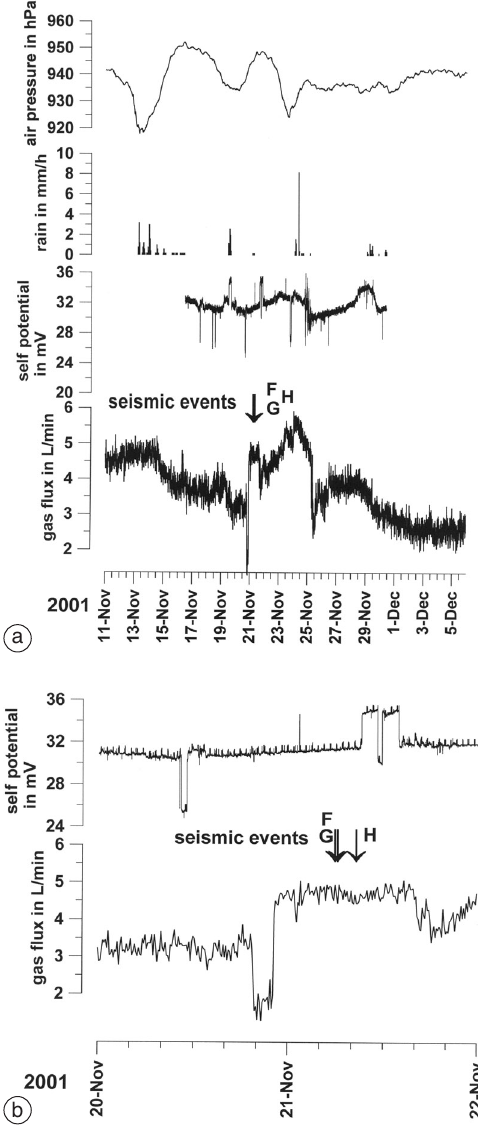
Fig. 5a,b. a) Temporal variation of the gas flux, rain and atmospheric pressure recorded at the Tramutola station and the self potential signal recorded at Mar- sico Nuovo in the period from November 11 to De- cember 6, 2001. Local seismic events in that period: F, G and H. b) Enlarged part of the temporal varia- tion of gas flux and self potential signal in the anom- alous period from November 20 to 22, 2001.